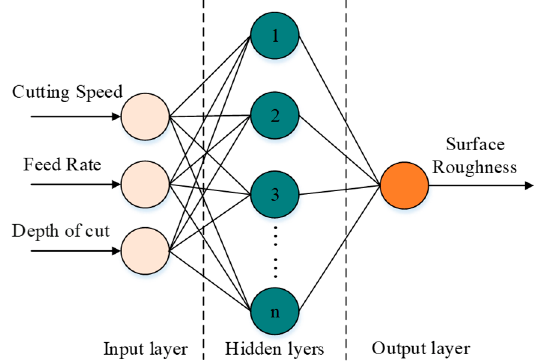
Figure 2. Neural network 3-n-1 structure.